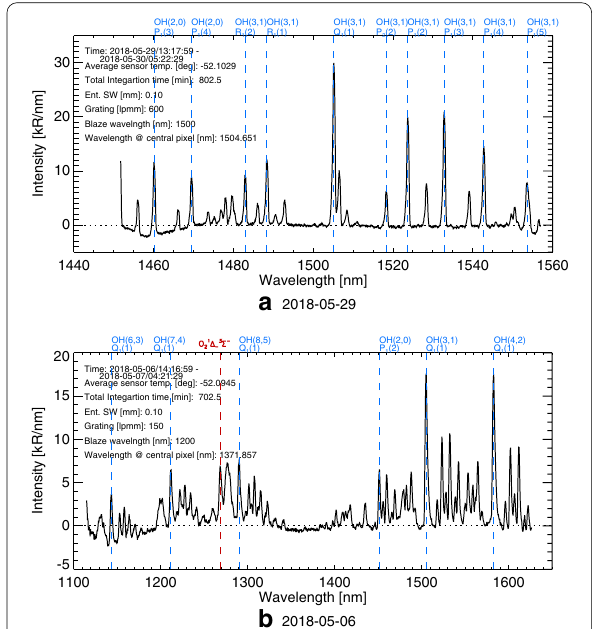
Fig. 2 Typical nightly mean spectrum obtained from NIRAS measurements on May 29 and May 6, 2018. a A spectra with the 600-lpmm grating and a center wavelength of 1504 nm. b A spectra with the 150-lpmm grating and a center wavelength of 1371 nm. It should be noted that data near the edge on a short wavelength side is not reliable, and therefore not used for quantitative discussions